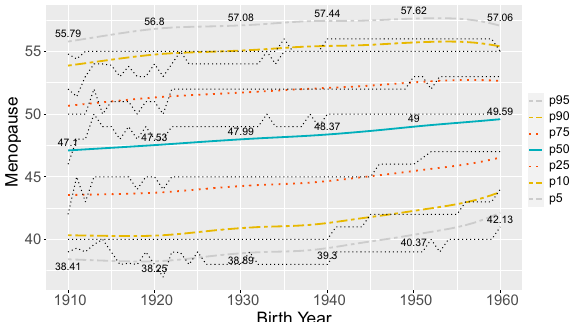
Figure 2. Estimated percentile curves for the age at menopause by year of birth since 1910. The values printed are for the percentiles 5%, 50% and 95% for the years 1910, . . . , 1960 . Lines with small black dots represent the correspondent observed